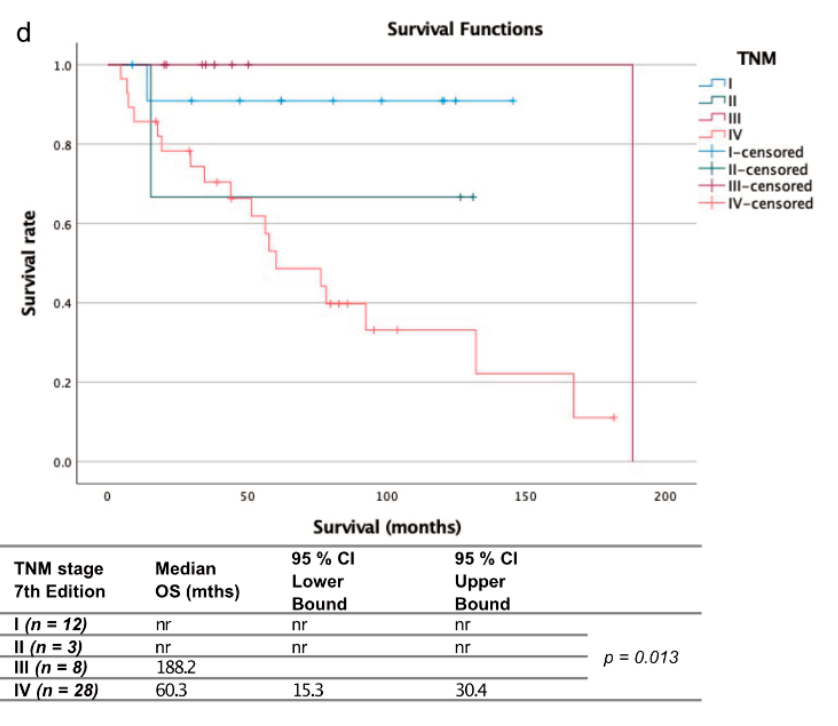
Figure 3. Kaplan-Meier curves and charts showing the overall survival of patients with vs. without 18 F-FDG-avid tumor at initial FDG-PET ( a ), with metabolic tumor volume/total lesion glycolysis (MTV/TLG) in the upper quartile ( b ) vs. the remaining patients with FDG-avid tumor, patients with early Tg progression vs. those without ( c ) and stratified by the AJCC/TNM stage according to the 7th edition ( d ). nr = not